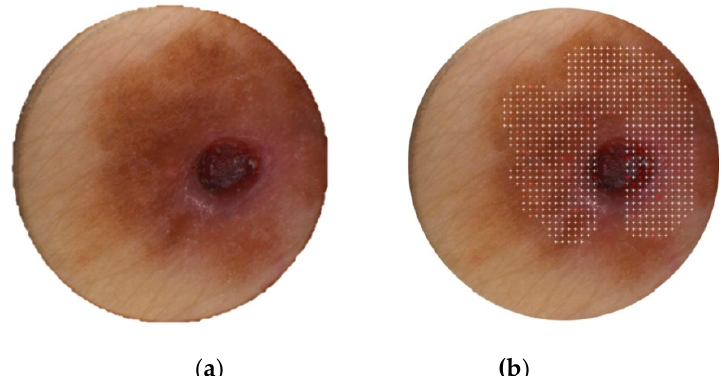
Figure 4. ( a ) The pigmented skin lesions (PSLs) not recognized as melanoma with dermatofluoroscopy. According to two of three pathologists, the lesion is an example of surface- spreading melanoma (SSM); ( b ) note the questionable scan area chosen.